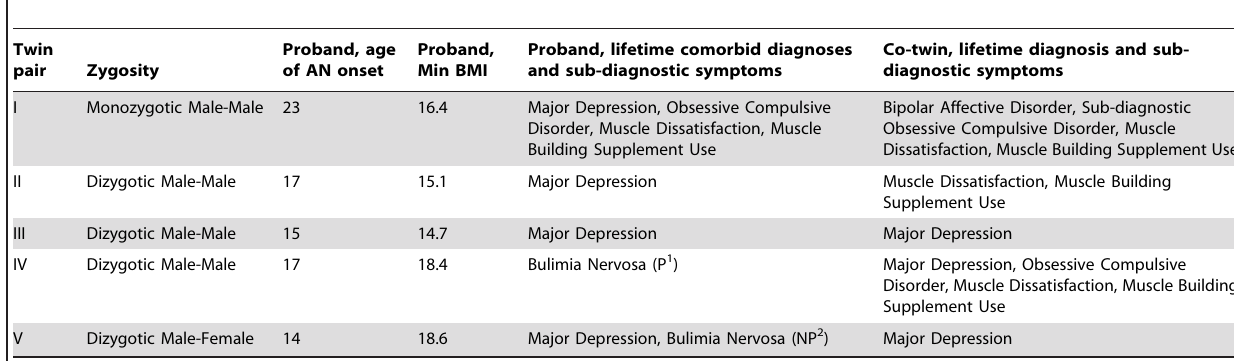
Table 1. Characteristics of the male anorexia nervosa probands and their co-twins in the population-based FinnTwin16 study.